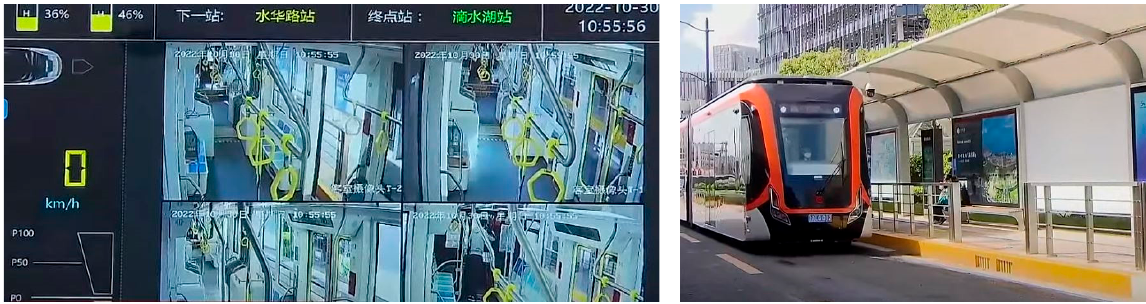
Figure 23. China’s hydrogen fuel cell zero-emission trolley in service in 2022 [57].